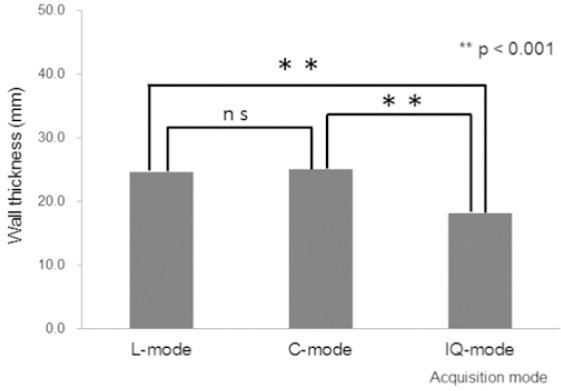
Correlations among C-, L- and IQ-modes.Myocardial wall thickness was lower with IQ-mode than C-mode and L-mode at FWHM of phantom. NS, not significant.